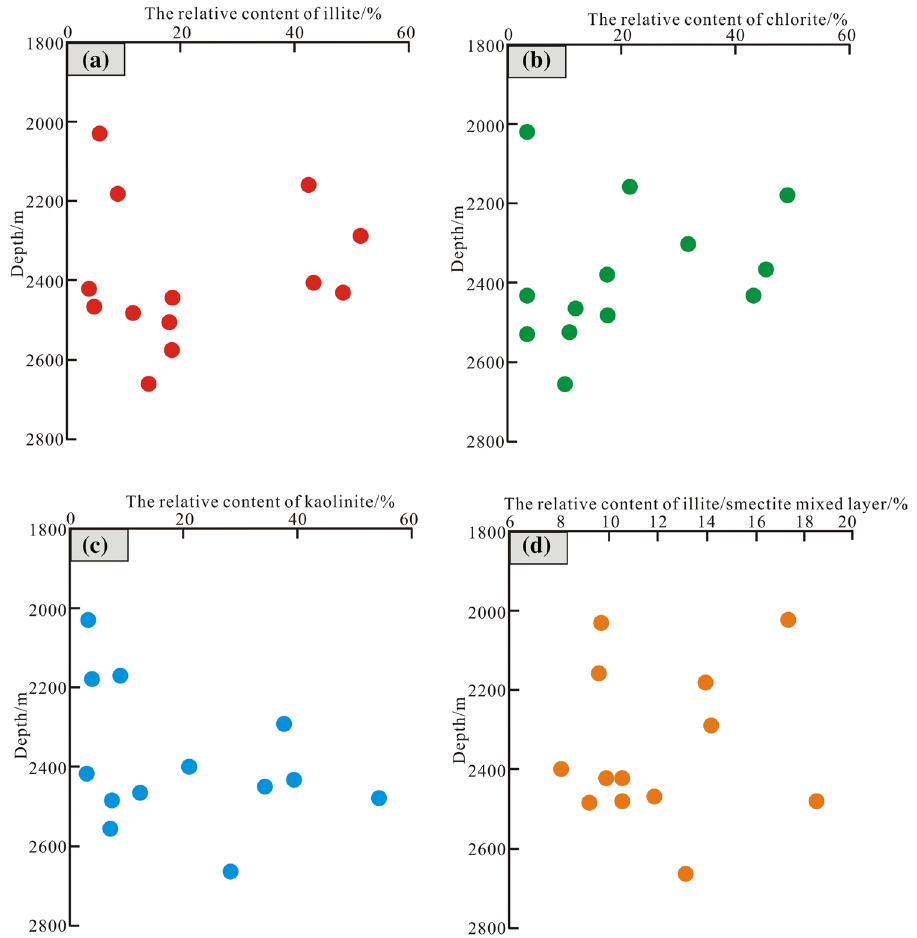
Fig. 8 Relationship between contents of different clay miner- als and burial depth in Chang 8 1